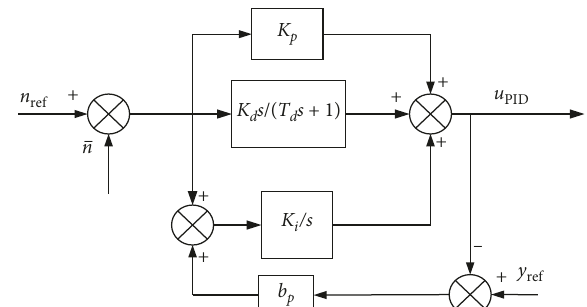
Figure 3: The parallel PID